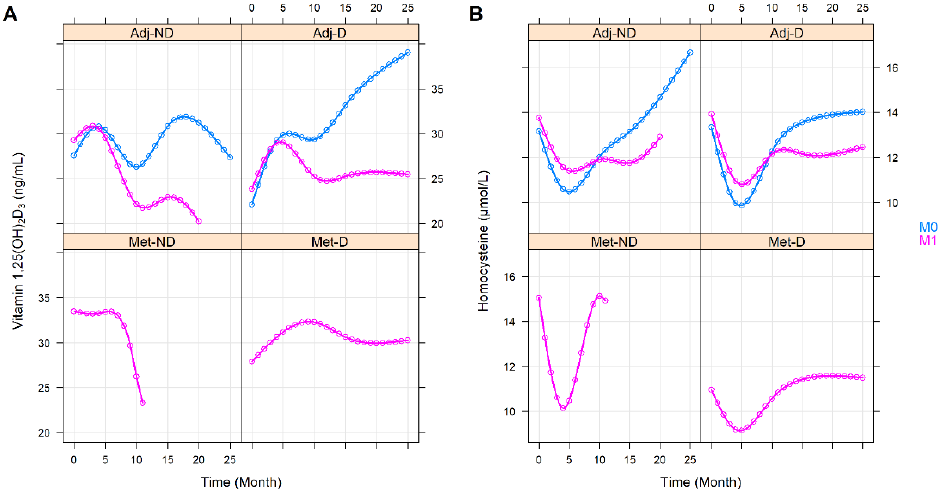
Figure 4. Predictions of average longitudinal changes in vitamin 1,25(OH) 2 D 3 ( A ) and homocysteine ( B ) level of the study groups throughout the first 25 months of the observation time, stratified by metastases that developed at a later stage of the disease. M0: without metastasis; M1: with metastasis. Adj-ND: patients without metastasis and no vitamin D 3 supplementation; Adj-D: patients without metastasis with vitamin D 3 supplementation; Met-ND: patients with metastasis and no vitamin D 3 supplementation; Met-D: patients with metastasis with vitamin D 3